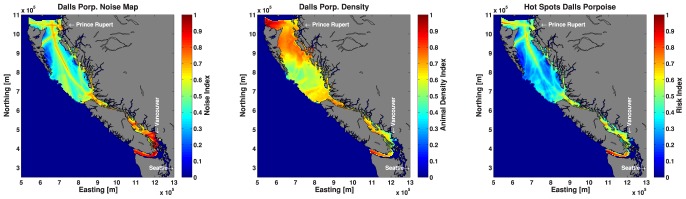
Audibility map for Dall's porpoise (left), Dall's porpoise density map (middle) and resulting map of hotspots (right).